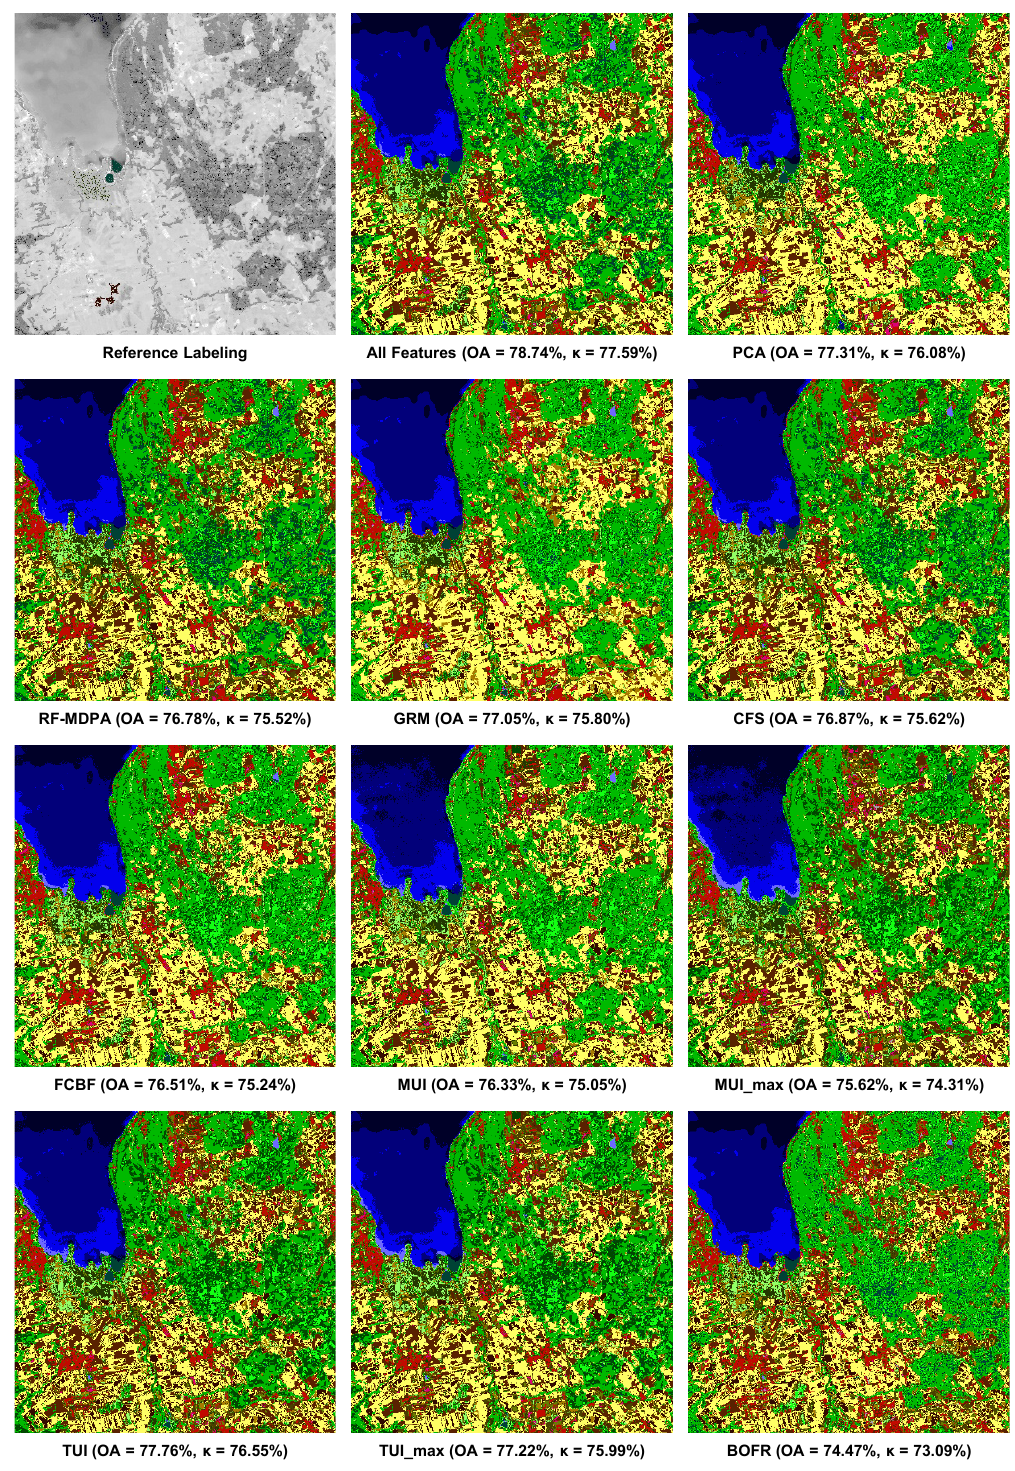
Figure 15. Part of the classified scene for the EnMAP dataset when using the RF classifier and different feature sets. The values in brackets refer to the evaluation on the test